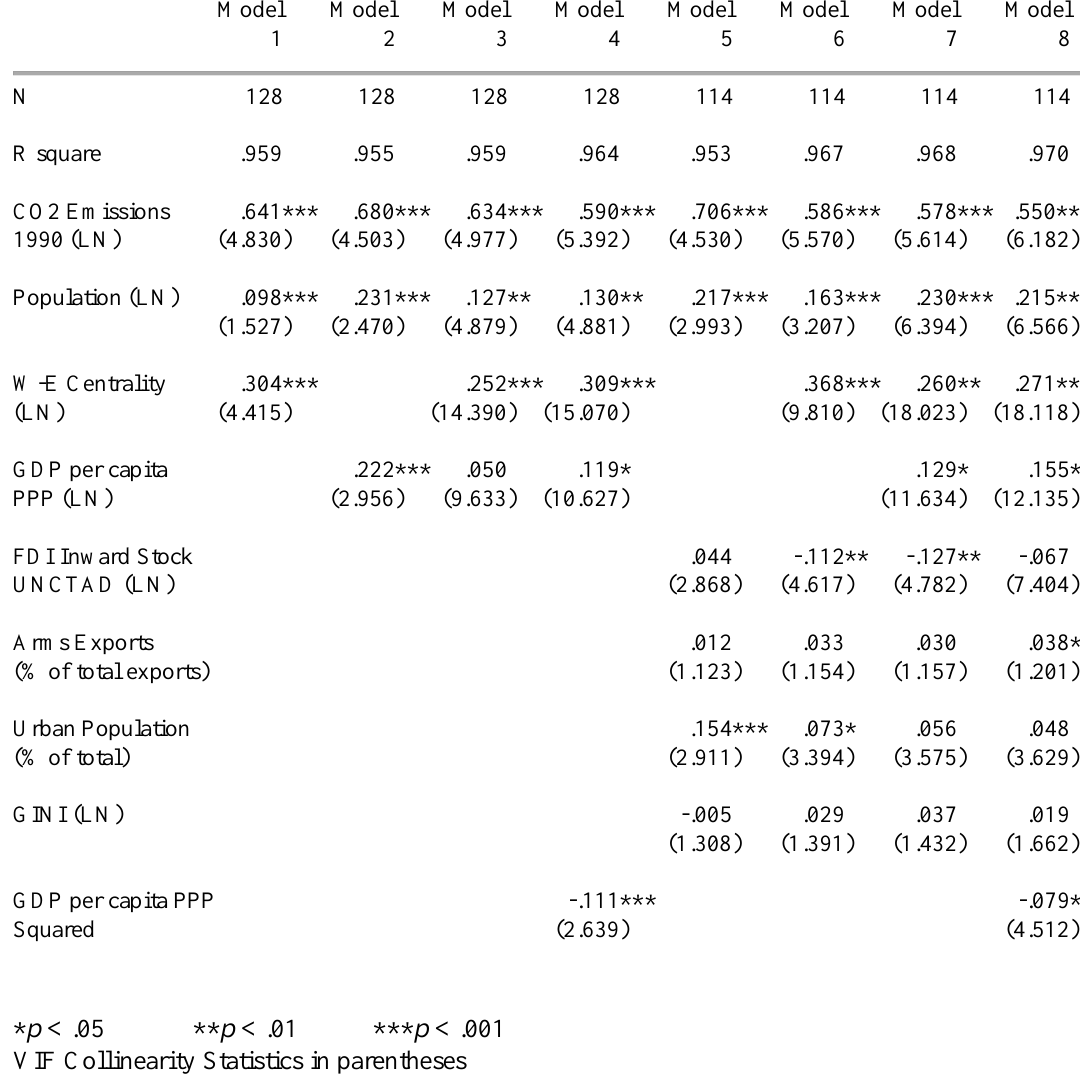
Table 2. Standardized Regression Coefficients for Carbon Dioxide Emissions: 128